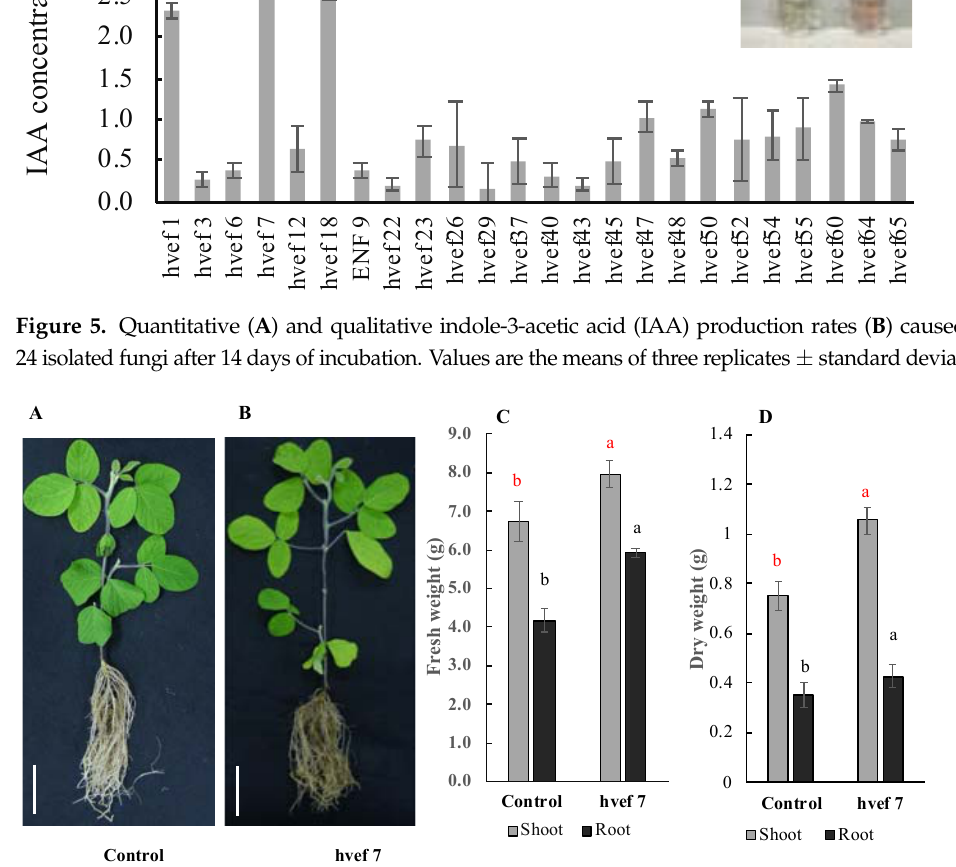
Figure 6. Soybean plant without inoculation (A) and with inoculation of hvef7 (B), soybean shoot and root fresh weights (C), shoot and root dry weights (D) after 25 days inoculation with hvef7 ( Cladosporium cladosporioides ) compared with control plants. Data were statistically different at p < 0.05 as assessed by one ‐ way ANOVA with Tukey’s test (n= 5); means ± SD. For each inoculation treatment, bars with different letters (a, b) indicate that the mean values are significantly different at a significance level of p < 0.05.